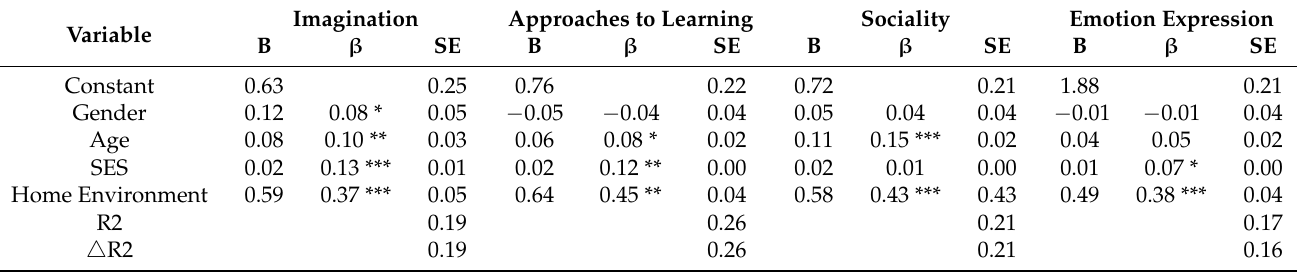
Table 3. Regression Coefficients of Family SES and Home Environment on Children’s Play Behaviors 1 .